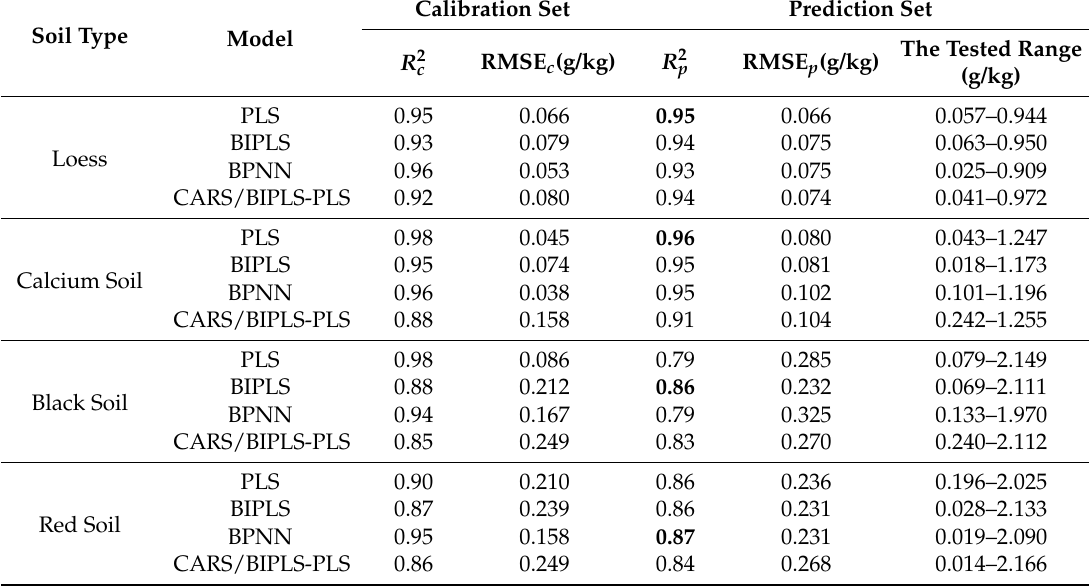
Table 3. The R 2 and RMSE values of four kinds of soils (loess, calcium soil, black soil and red soil) modeled by full wavebands (PLS, BIPLS, BPNN) and sensitive wavebands